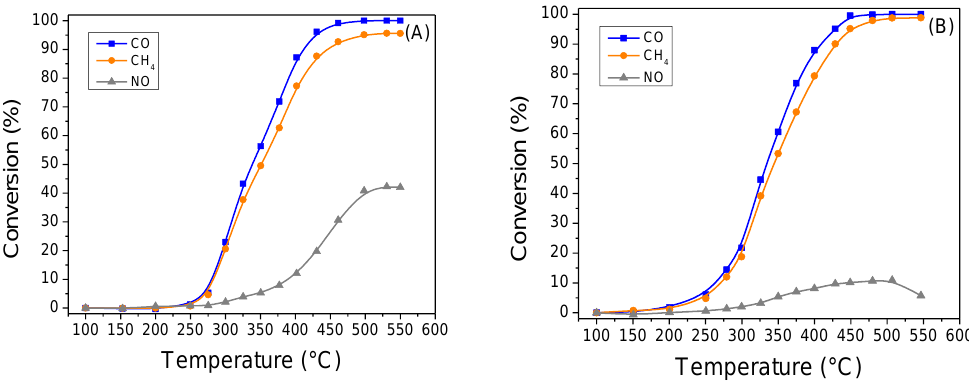
Figure 10. Light-off curves of the conversion of CO, CH 4 and NO of PROM100-aged catalytic washcoat: ( A ) under rich-burn conditions ( λ = 0.99) and ( B ) under lean-burn conditions ( λ = 1.03).